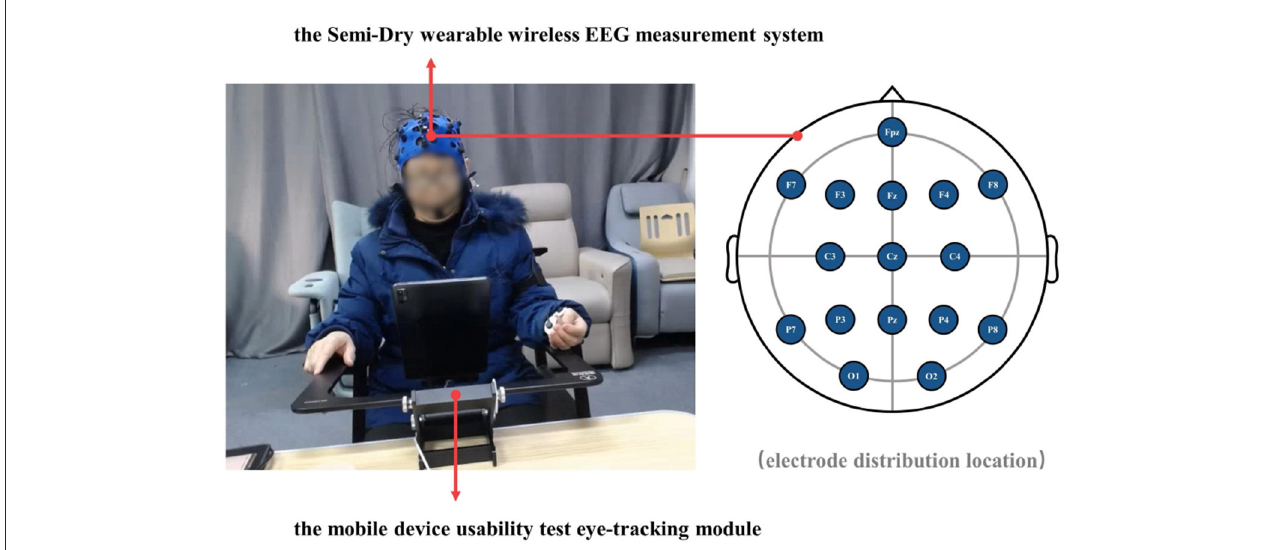
FIGURE3 The experimental equipment and the distribution of the electrodes used in the experiments.